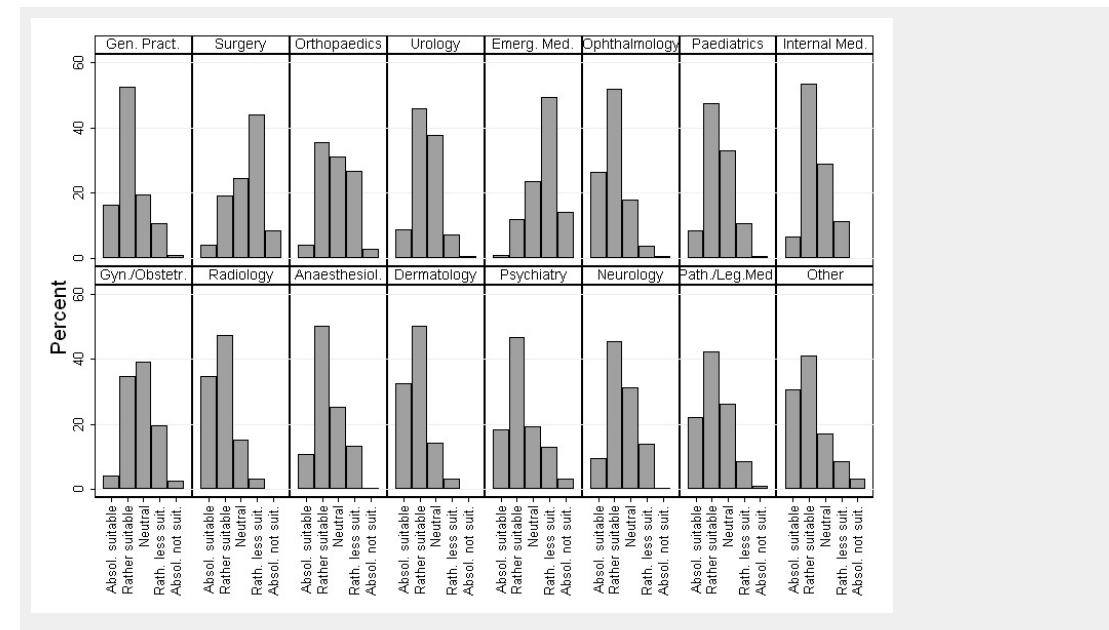
To what extent are different medical specialities suitable to satisfy your work environment expectations? Please assign a value to each option. (Answering options with five descriptors: absolutely suitable – rather suitable – neutral – rather less suitable – absolutely not suitable). Anaesthesiol. = anaesthesiology; Emerg. Med. = emergency medicine; Gen. Pract = general practitioner; Gyn./Obstetr. = gynaecology/ obstetrics; Internal Med. = internal medicine; Path./Leg.Med. = pathology/legal medicine